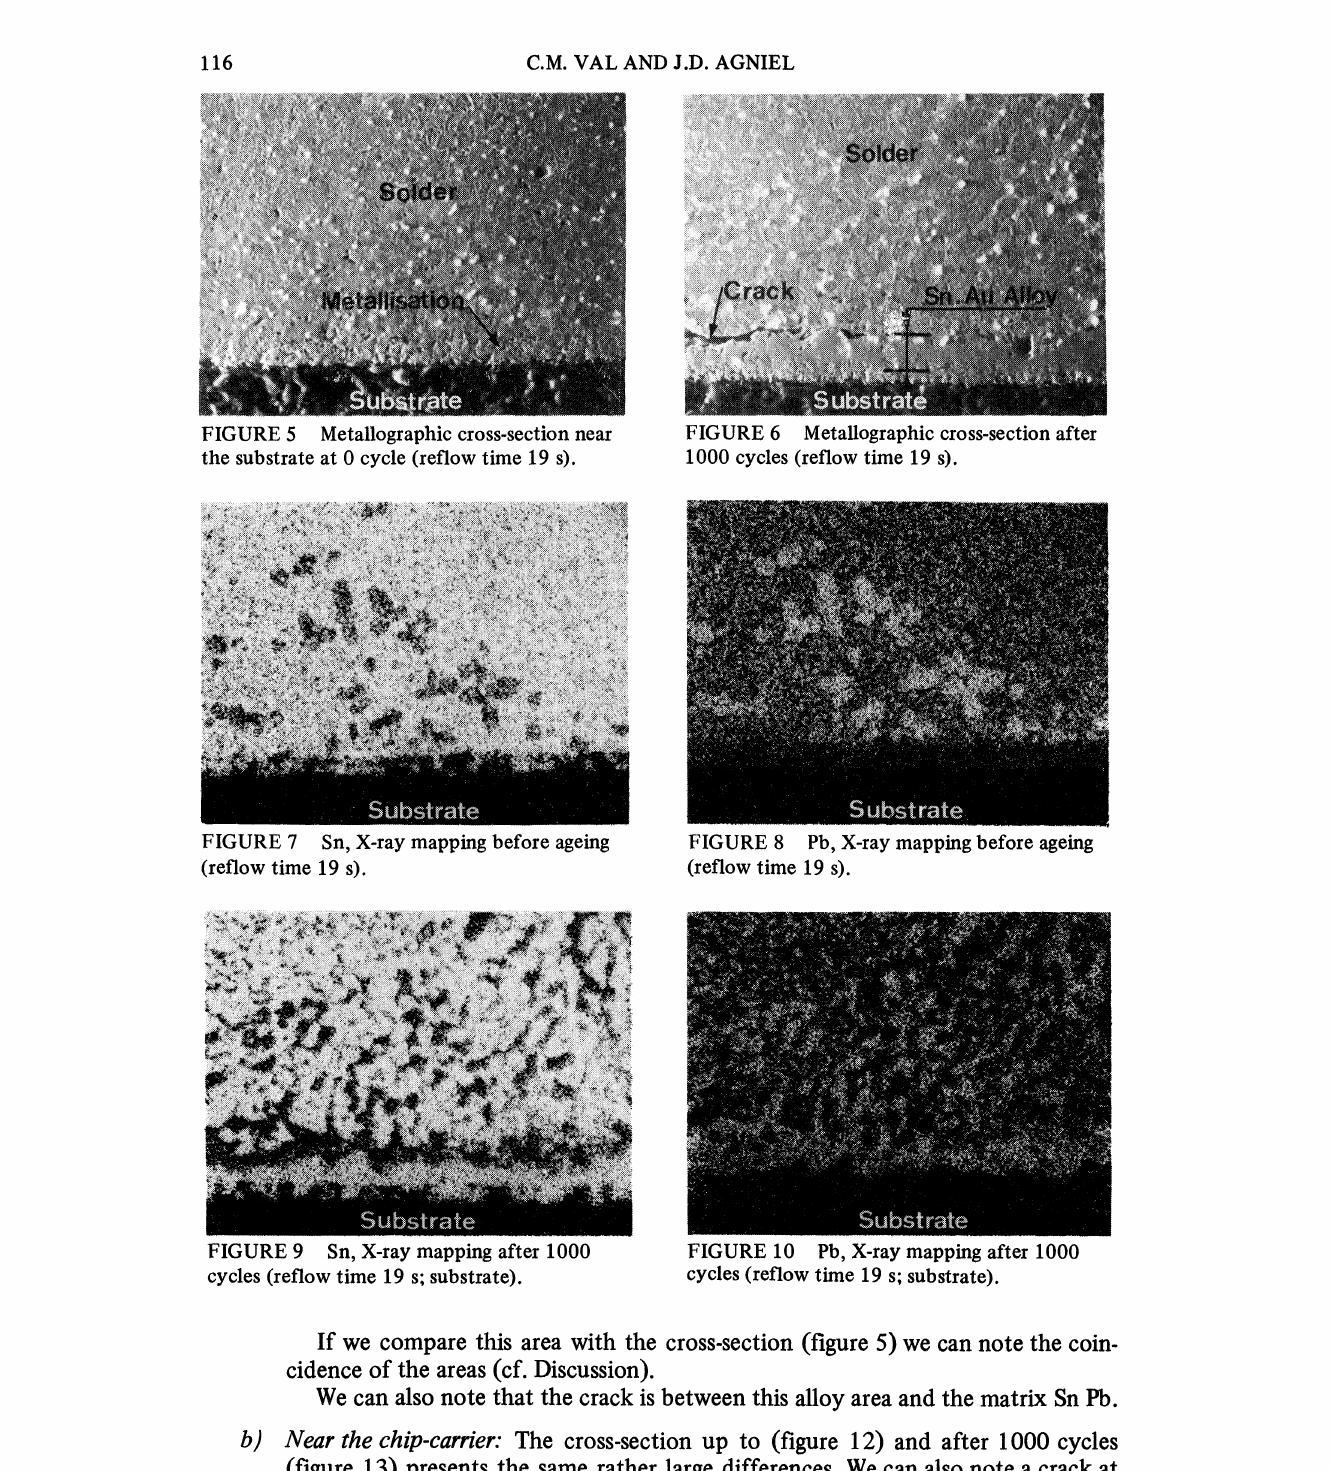
FIGURE 9 Sn, X-ray mapping after 1000 cycles (reflow time 19 s; substrate).